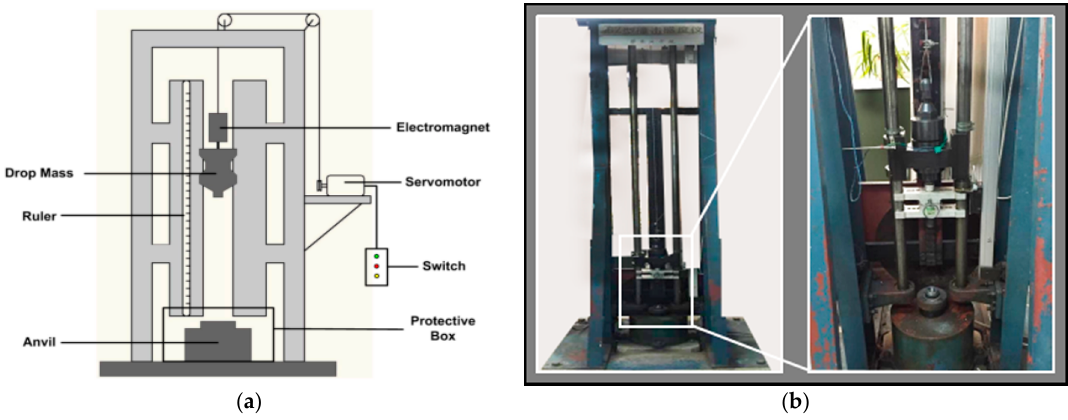
Figure 4. Drop-weight apparatus. ( a ) schematic illustration; ( b ) actual apparatus.